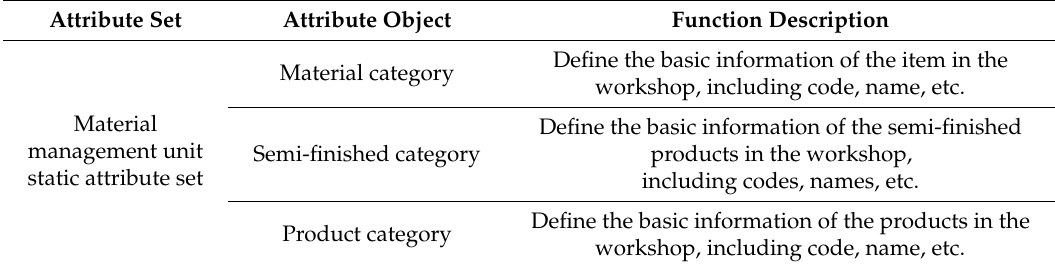
Table 3. Attribute objects and function descriptions contained by material management unit